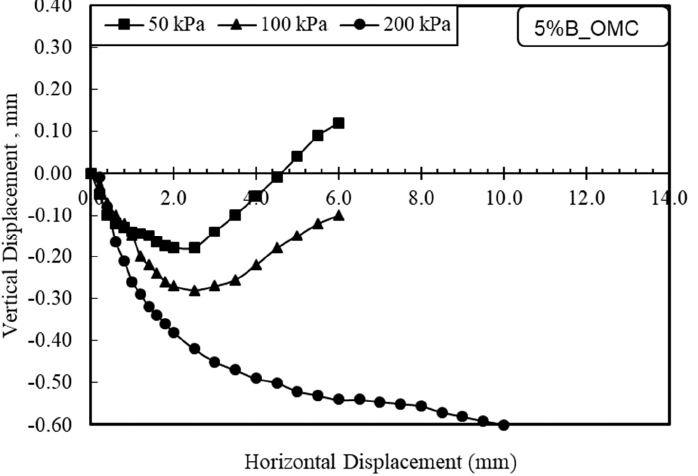
Figure 11. Horizontal displacement vs. vertical displacement for mixture with 5% bentonite under OMC condition.